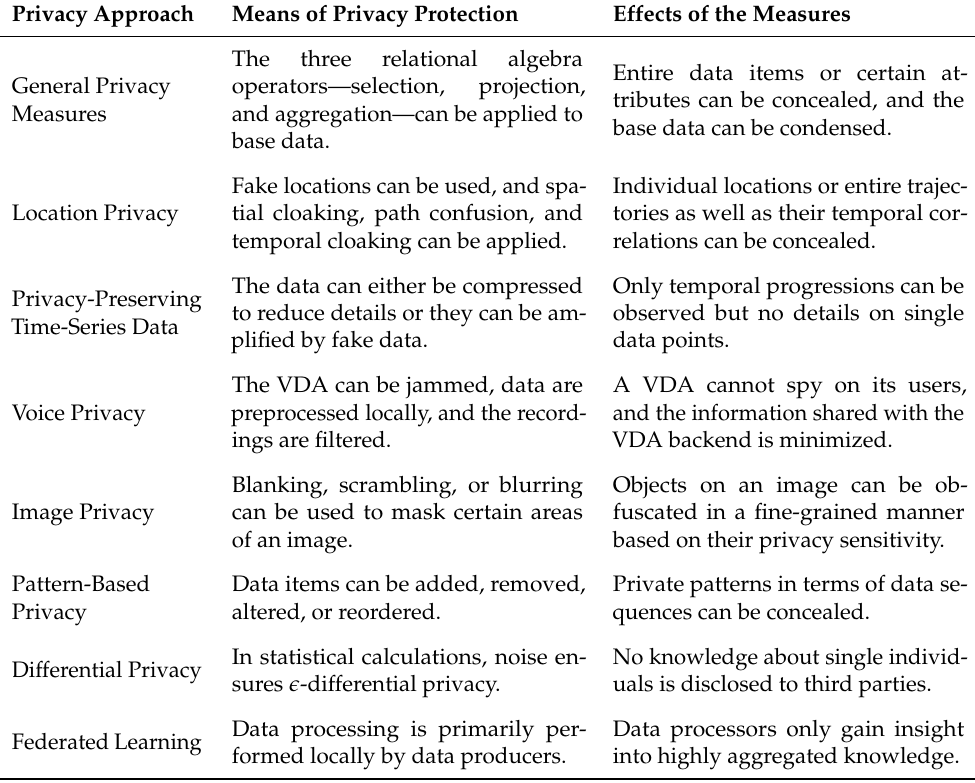
Table 2. Summary of the Key Lessons Learned from the Review of the Privacy